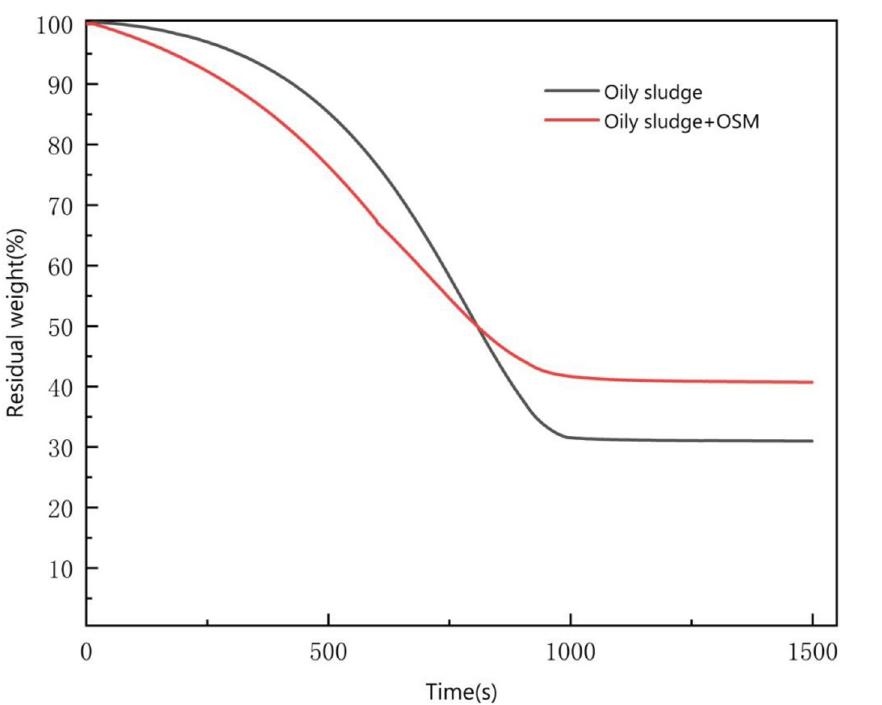
Fig 7. Thermo gravimetric analysis (TGA)